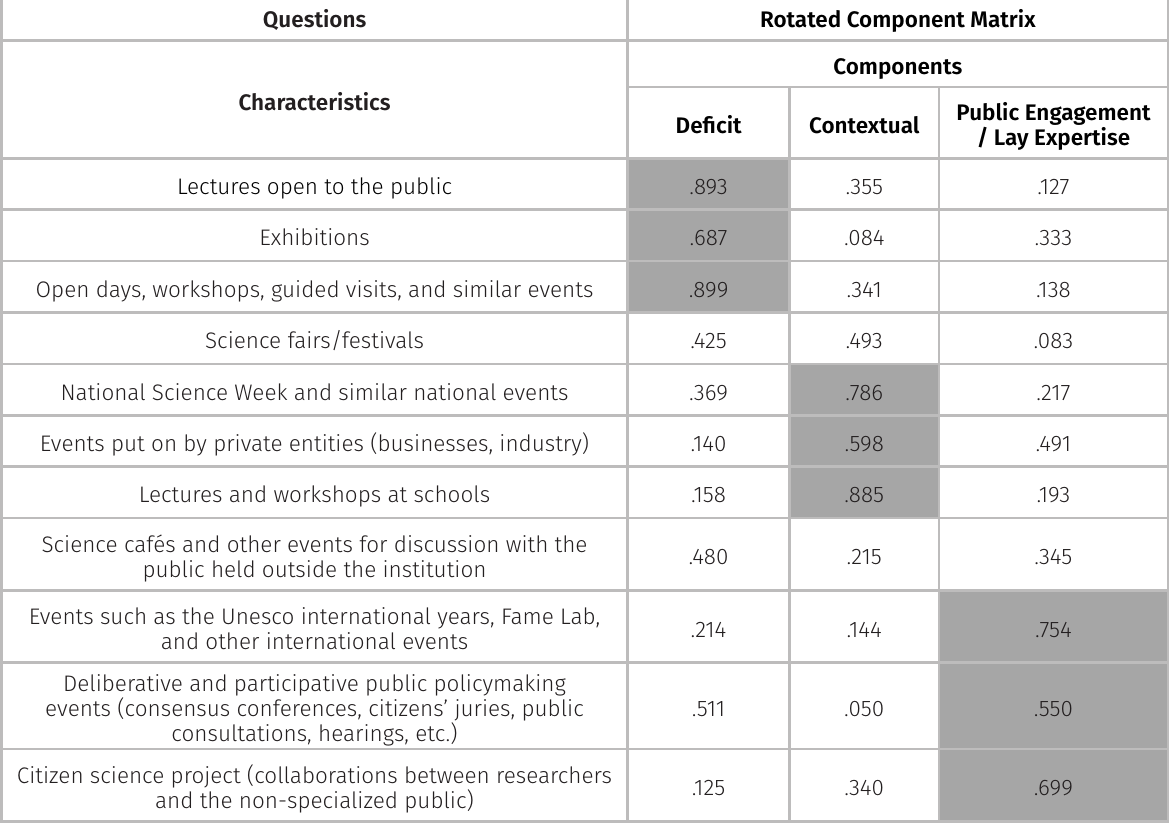
Table II. Matrix of components of participation as an organizer or collaborator in science communication events.